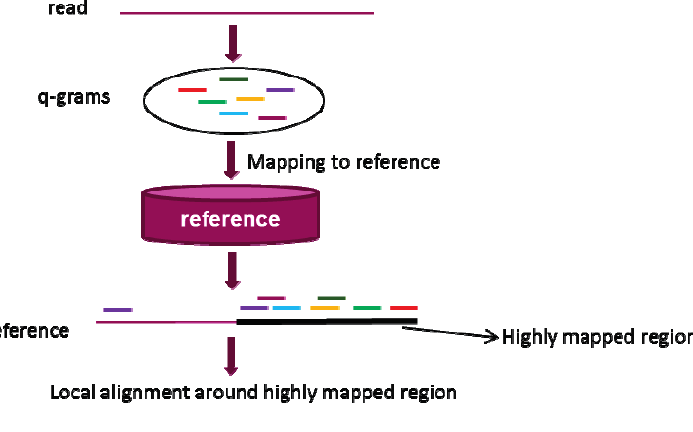
Figure 3. The overall workflow of q-gram filter in alignment. The strategy consists of three steps: (1) generation of q-grams from a read; (2) identification of highly mapped regions in a reference sequence through multiple q-grams mapping; and (3) local alignment of the read and highly mapped regions through standard dynamic programming algorithms based on Needleman–Wunsch (NW) [78] algorithm or Smith–Waterman (SW) algorithm